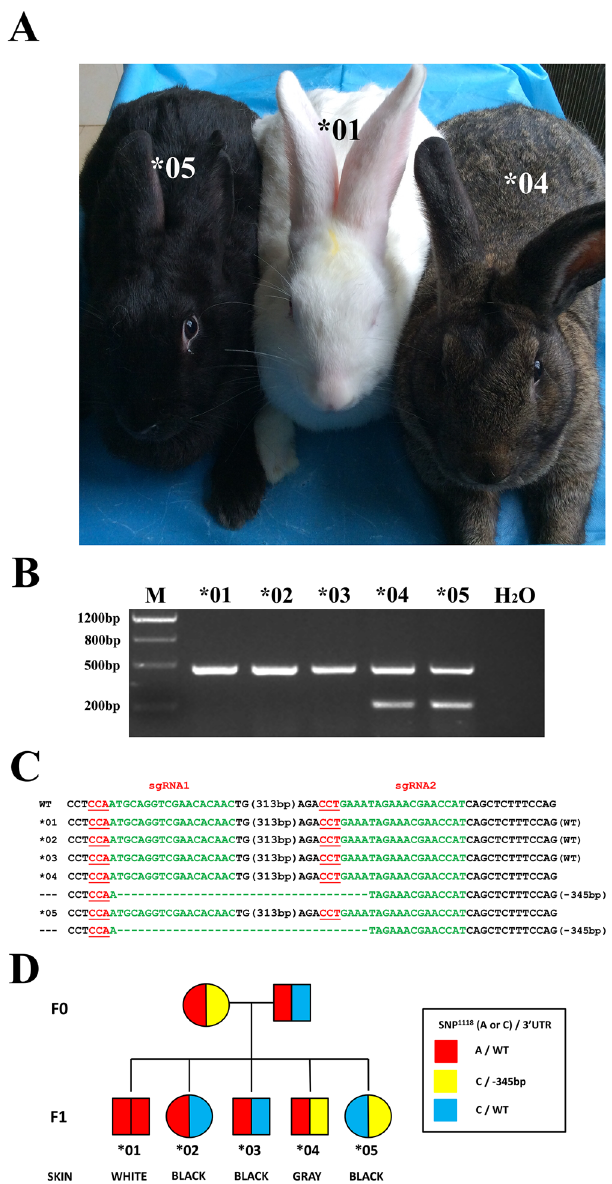
Figure 4. Heritability of Tyr 3 ′ UTR deleted rabbit. ( A ) The F1 pups with different skin color. ( B ) Mutation detection in F1 rabbits by PCR. The results demonstrated that the Tyr 3 ′ UTR deletions were determined in * 04 and * 05. M, DNA marker III. Original images are included “Authors’ original file for Fig. 4B”. ( C ) T-cloning sequence analysis of the F1 rabbits. The PAM sites are underlined and highlighted in red; the target sequences are green; deletions ( − ) and insertions ( + ) are shown. BR, black rabbit; WR, white rabbit; KO, Tyr 3 ′ UTR deleted rabbits. ( D ) A pedigree obtained from analyses in ( C ). The identical alleles are shown by the same colors. The large deletion of Tyr 3 ′ UTR in F0 is heritability transmitted to the F1 pups. SNP 1118 , the SNP sites (A/C) located in the Tyr